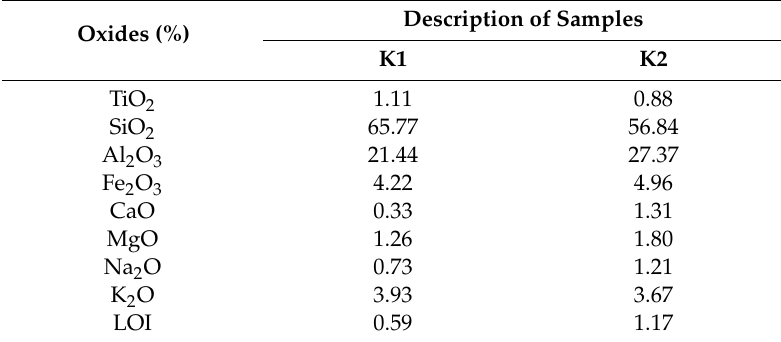
Table 2. Chemical composition of coal gangue.